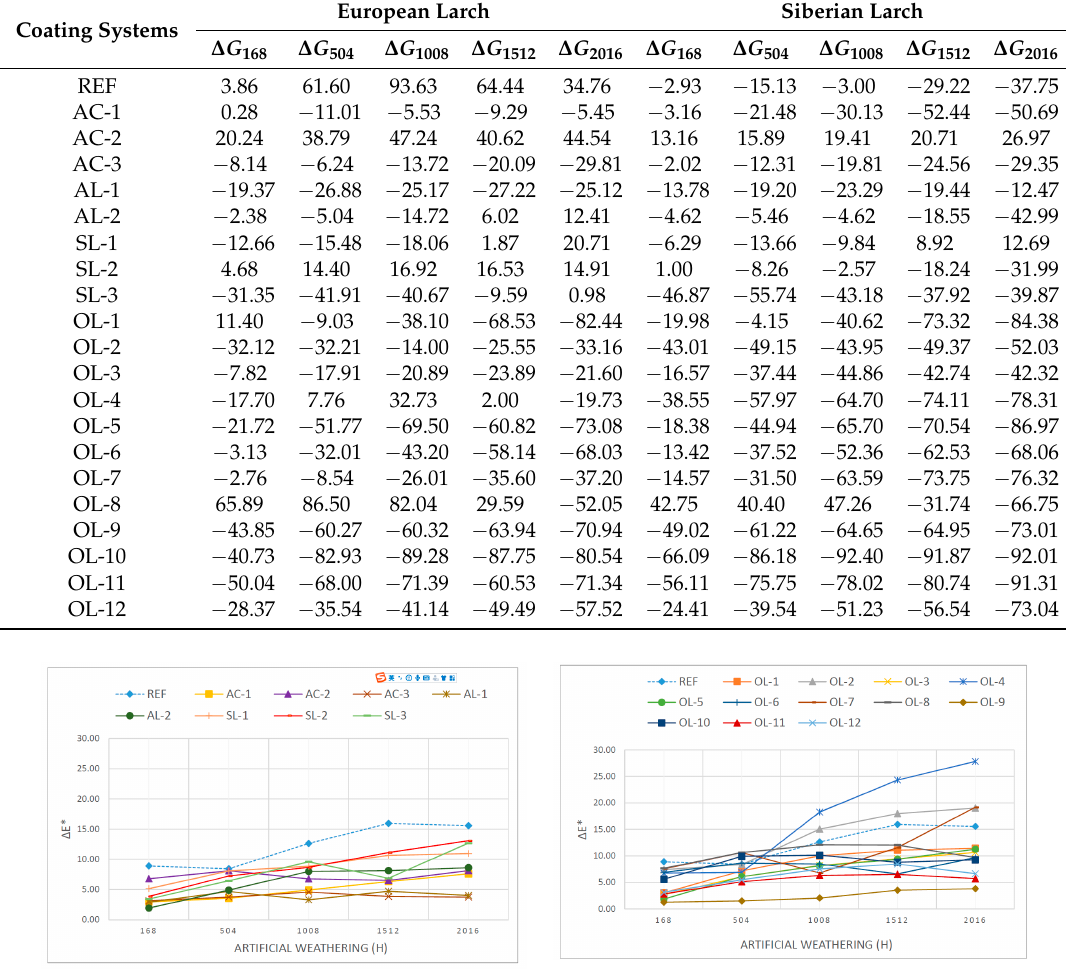
Table 3. Gloss changes of tested coatings on the European and Siberian larch during artificial weathering.